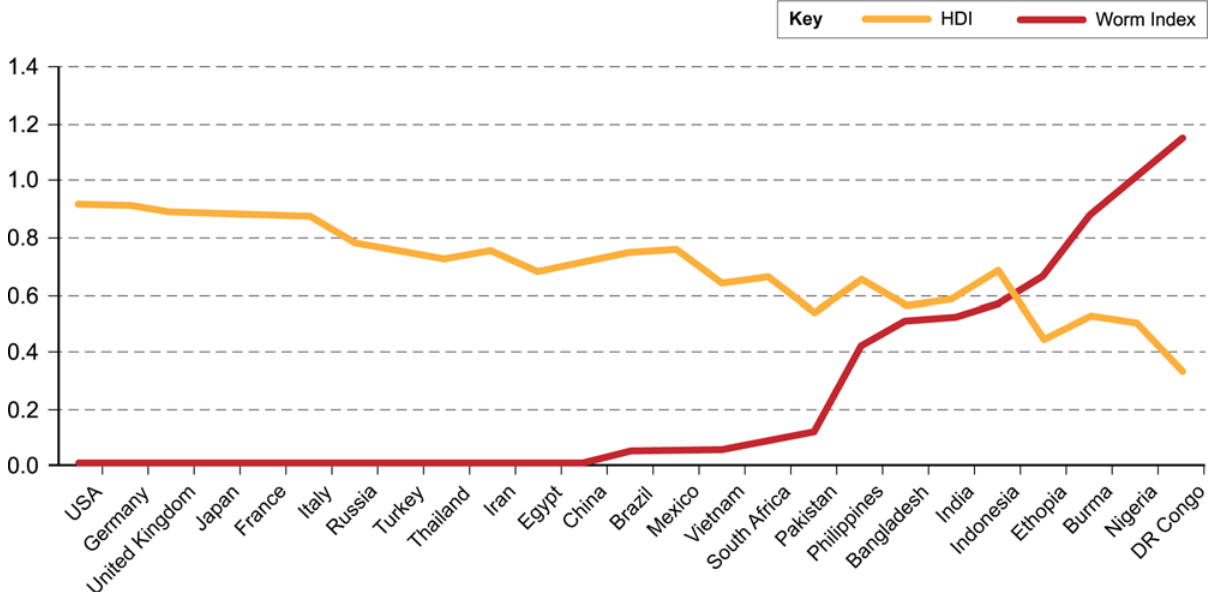
Fig 1. Comparison of worm index vs. HDI (based on data in Table